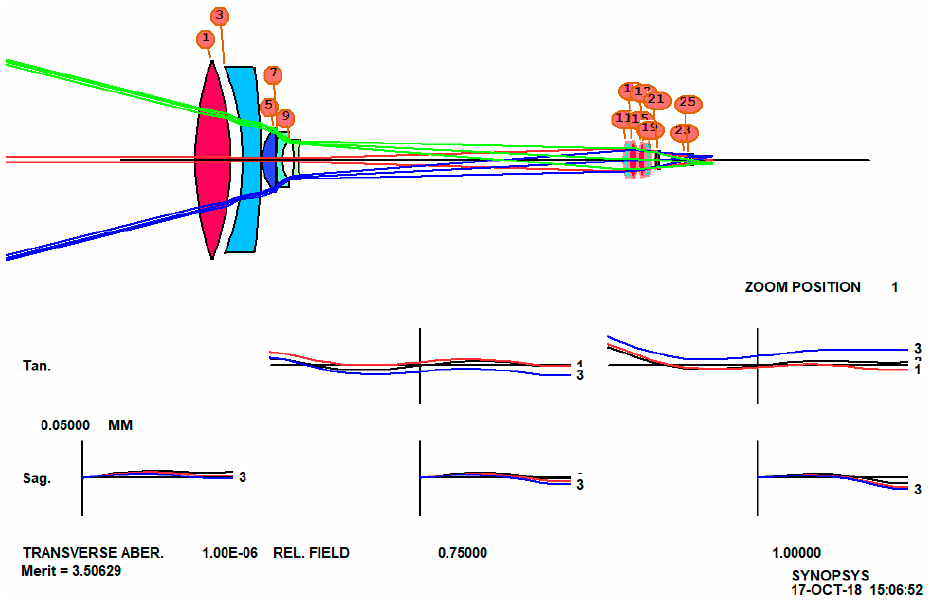
Figure 13. Zoom lens with thicknesses adjusted by the software, in zoom 1. J. Imaging 2018 , 4 , x FOR PEER REVIEW